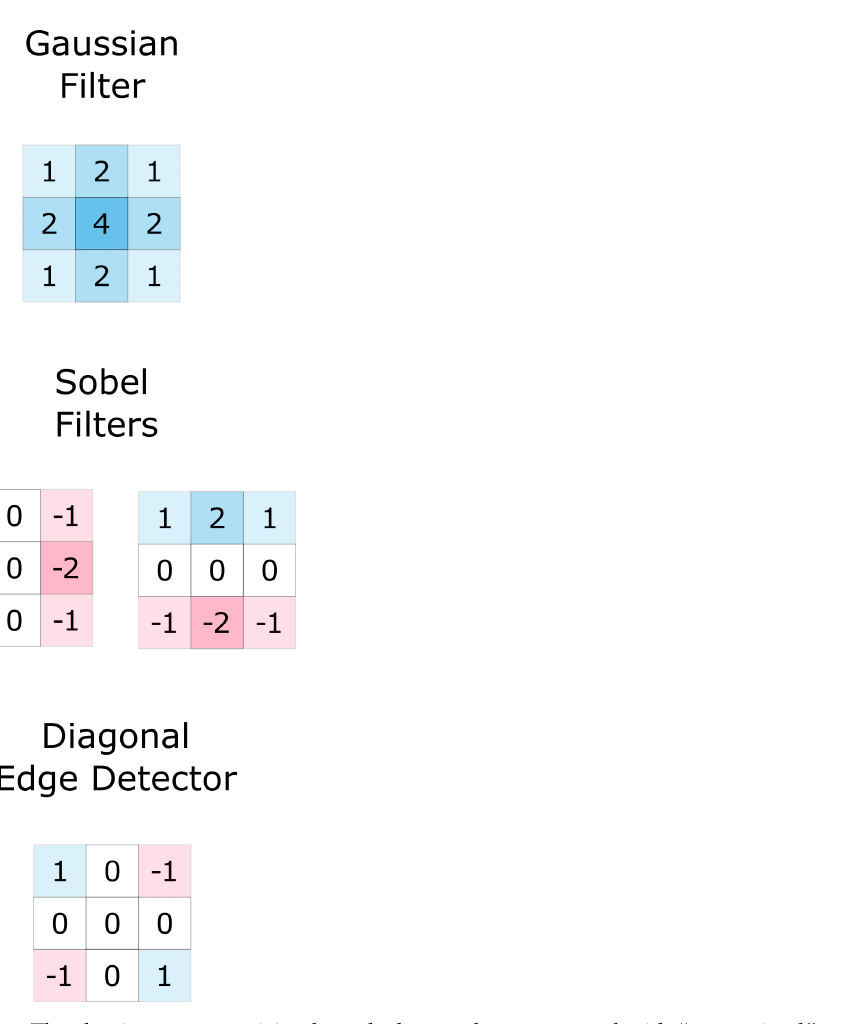
Figure 2. The classic computer vision kernels that can be constructed with “constrained” neural jet features (see Section 3.1).